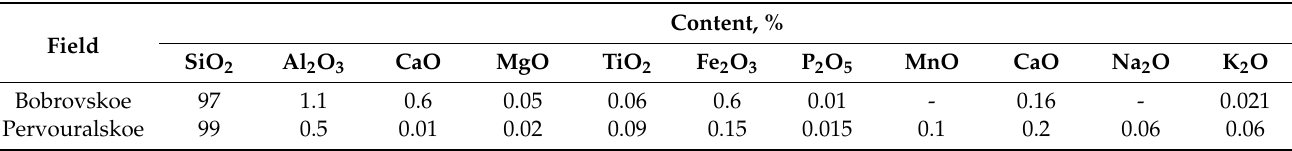
Table 1. Chemical composition of quartzites for lining induction